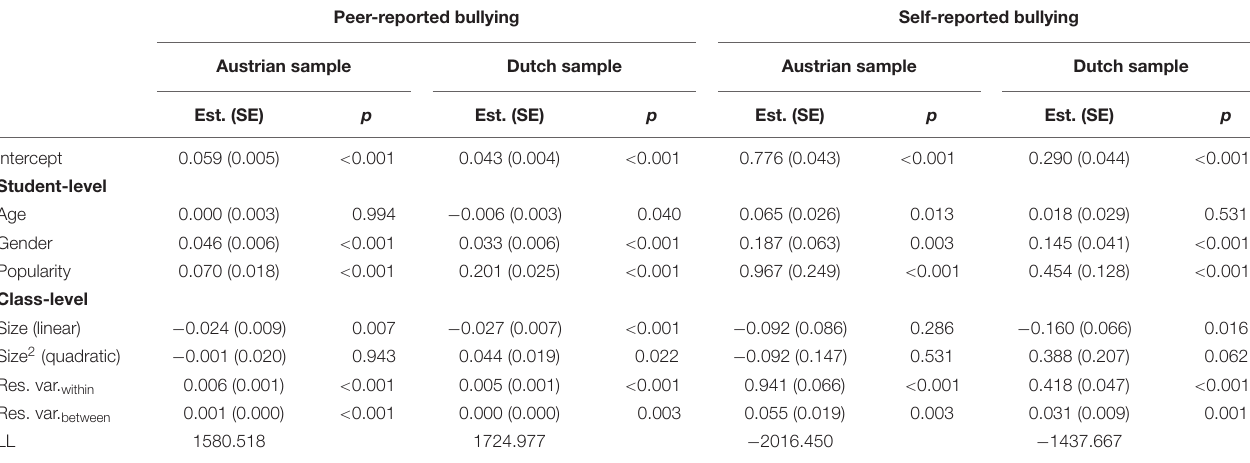
TABLE 2 | Main effects of age, gender, popularity and classroom size on peer-reported and self-reported bullying for the two